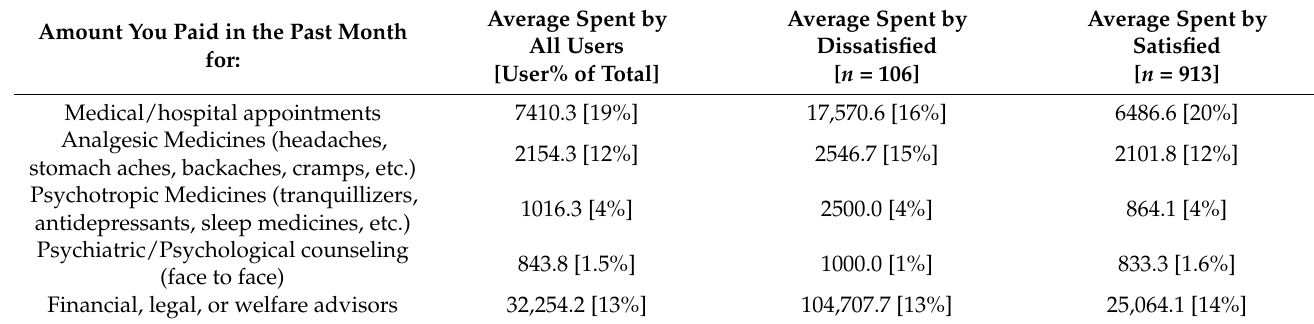
Table 4. Expense comparison of bereaved dissatisfied and satisfied with funerals.